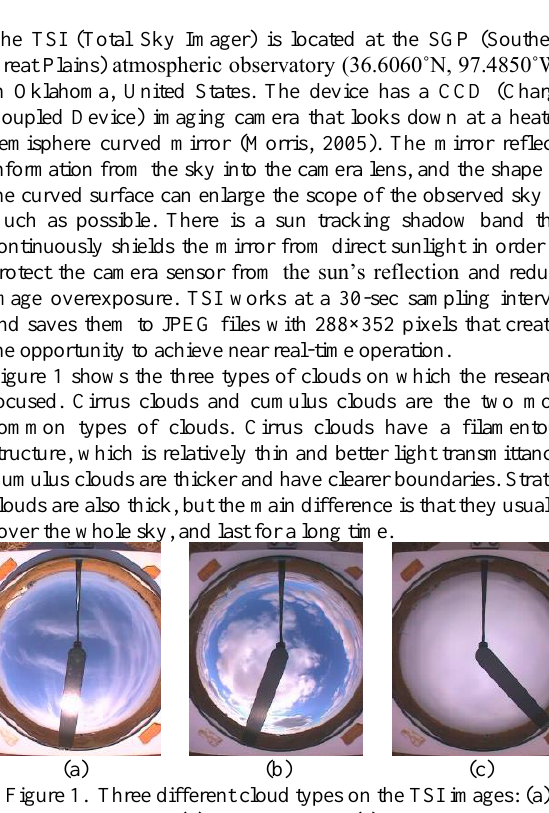
Figure 1. Three different cloud types on the TSI images: (a) Cirrus cloud; (b) Cumulus cloud;(c) Stratus cloud